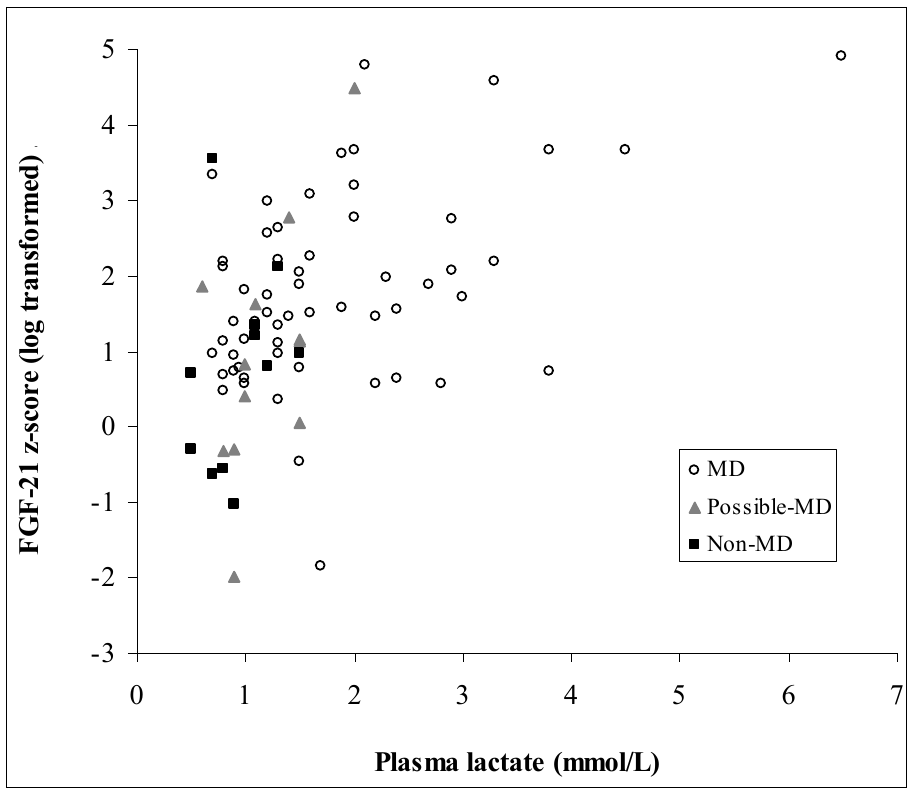
Figure 5. Relationship between log-transformed FGF-21 z -scores and plasma lactate in 80 patients (57 MD, 12 possible MD, and 11 non-MD), on whose specimens lactate values were available. A formula of FGF-21 z -score = 0.53 x lactate + 0.84 describes the relationship between the two measures ( R 2 = 0.205).